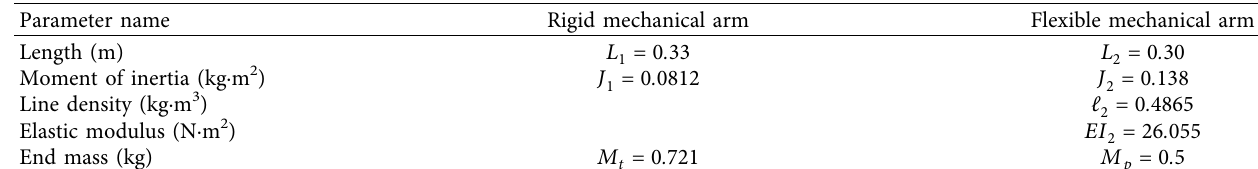
Table 1: Other parameter values of the rigid-flexible mechanical arms.